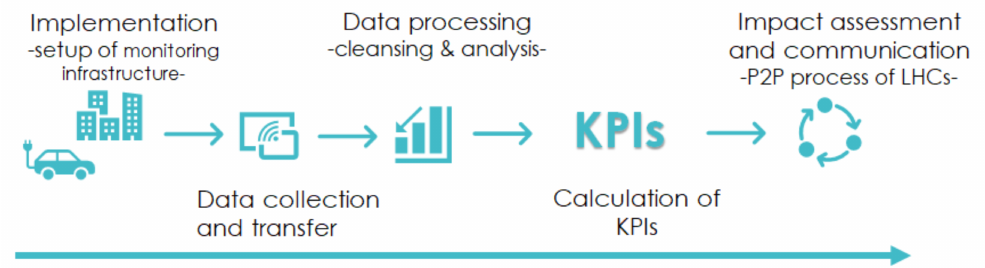
Figure 6. Flow diagram of the integrated monitoring process for the demonstration sites of the